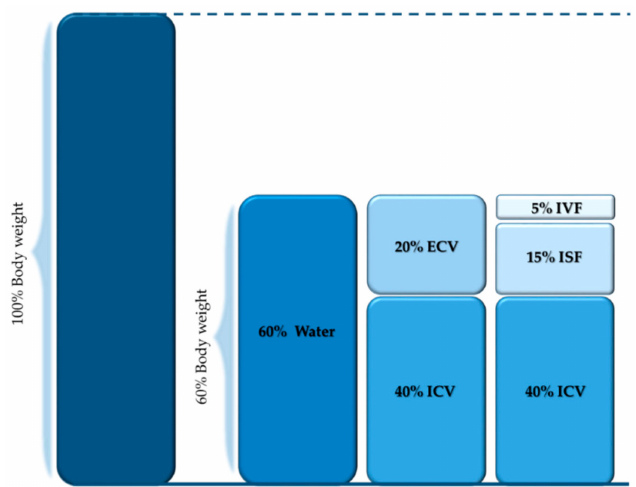
Figure 2. The repartition of body water within the di ff erent compartments as percentage of body weight [35]. ICV: Intracellular volume; ECV: Extracellular volume; ISF: Interstitial fluid; IVF: Intravascular fluids.